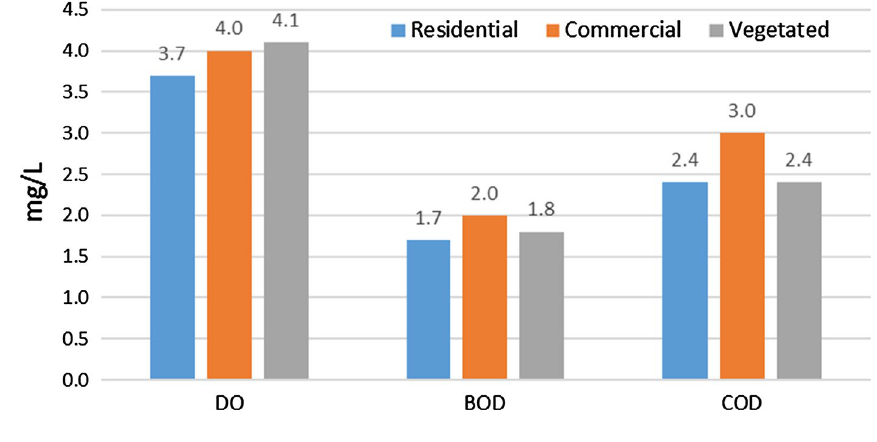
Fig. 9 Variation in DO, BOD and COD